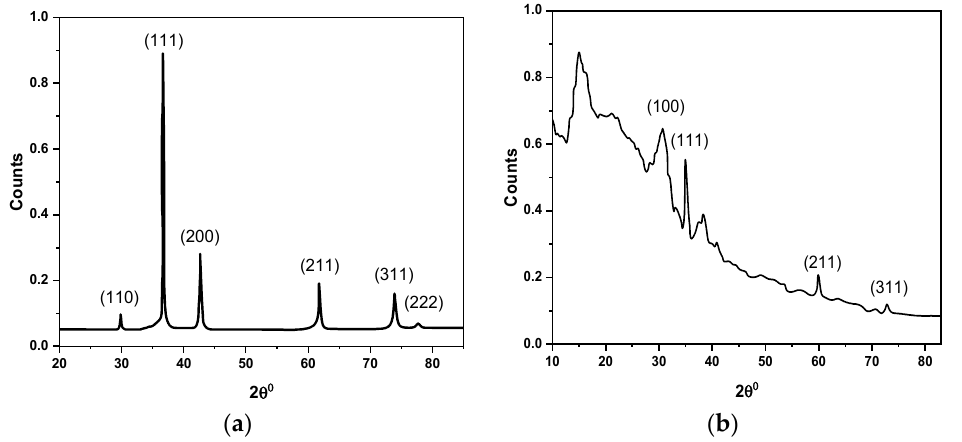
Figure 3. XRD spectra of ( a ) Cu 2 O nanoparticles; ( b ) F8-Cu 2 O nanocomposite. The FTIR spectra of Cu 2 O nanoparticles and F8-Cu 2 O nanocomposites are shown in Figure 4a,b, respectively. The spectra are measured in the energy range from 500 to 4000 cm − 1 where wavenumber vs. percent transmittance (%T) is plotted. The common strong peaks observed in both spectra at 623 and 625 cm − 1 indicate the vibration mode of Cu 2 O. The broad absorption peak at 957 cm − 1 is due to the C-H out-of-plane bending mode. The energy bands and their assigned bond dynamics observed in the FTIR spectra are presented in Table 1. The modes of vibration assigned to 957 and 1408 cm − 1 represent the out-of-plane bending and CH 2 bending mode, respectively. The C=C aromatic ring of benzene stretches are associated with the peak observed at 1670 cm − 1 . The peaks witnessed at 3056 cm − 1 identify a C-H stretch of π conjugation. Therefore, all the indicated peaks and bands observed confirm the chemical composition of the Cu 2 O and F8-Cu 2 O nanocomposite.